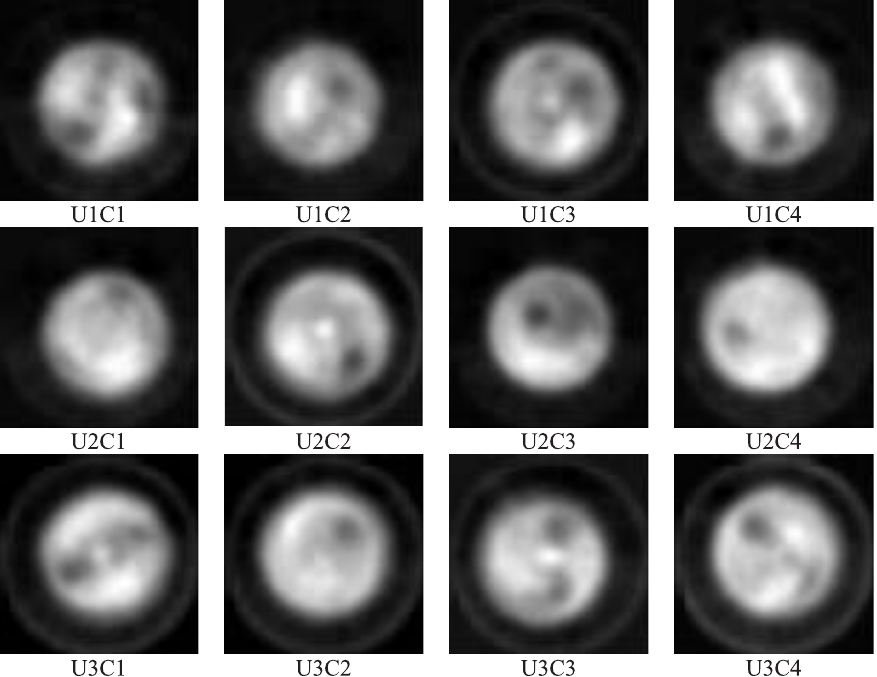
Figura 3. Imagens tomográficas da densidade média do solo na região da semente para os diferentes teores de água do solo e níveis de carga aplicada pela roda compactadora.